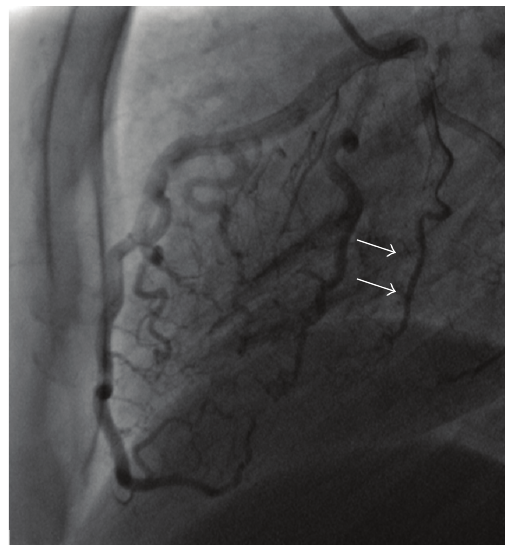
Figure 3: Selective coronary angiography shows multiple fistulae from the artery circumflex to the left ventricle (arrows).